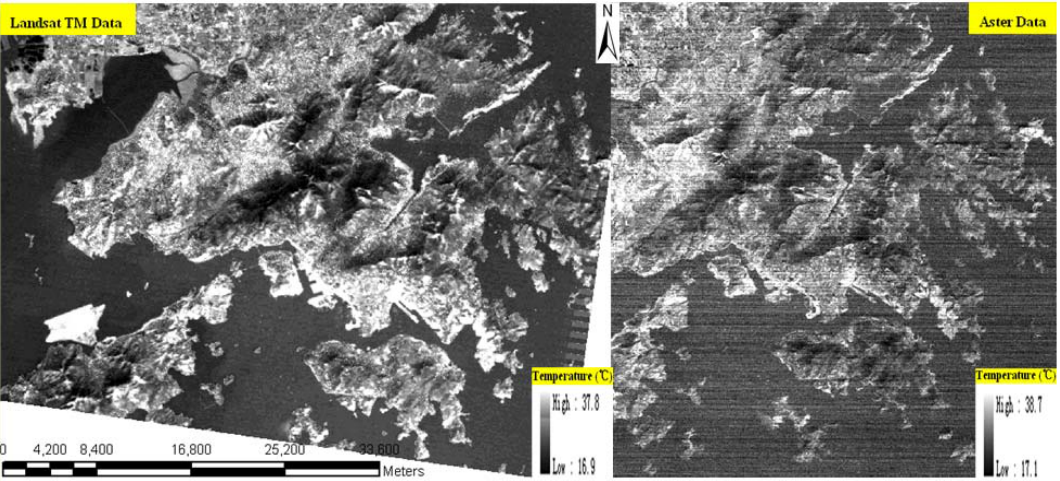
Figure 4. LST results for Hong Kong in 2005 from Landsat TM (left) and ASTER data